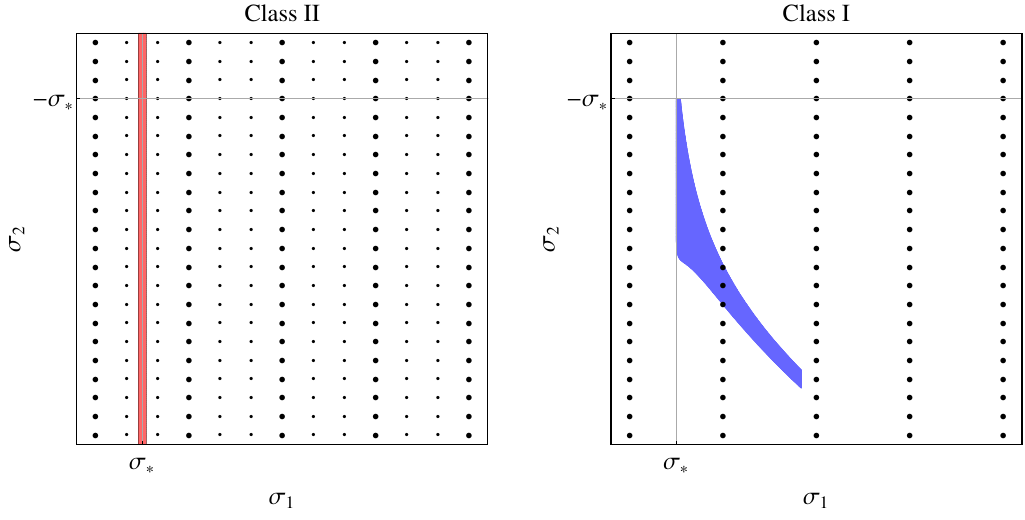
Figure 7 . Illustration of the scanning of the cosmological constant in the absence (Class II, left) and presence (Class I, right) of a radius stabilization mechanism. Dots correspond to vacua of the brane tensions (cid:27) 1 and (cid:27) 2 on the horizontal and vertical axes, with large dots indicating vacua with a near-critical Higgs mass. The shaded bands represent regions where the four-dimensional cosmological constant is smaller than some value (cid:3) 4 . The shape of the red region is independent of (cid:27) 2 in the unstabilized case, with a width in the (cid:27) 1 direction given by eq. (3.8). The overall shape of the blue region for a stabilized, warped bulk is given by eq. (3.44) (the analogous shape for a (cid:13)at bulk is described by eq. (3.29)). The fattening in the (cid:27) 2 direction as (cid:27) 1 approaches (cid:27) (cid:3) is due to the warping e(cid:11)ect of eq. (3.42), while the (cid:12)nite range in (cid:27) 1 arises because of the need for a large extra dimension to get repulsive Casimir stress (eqs. (3.16) and